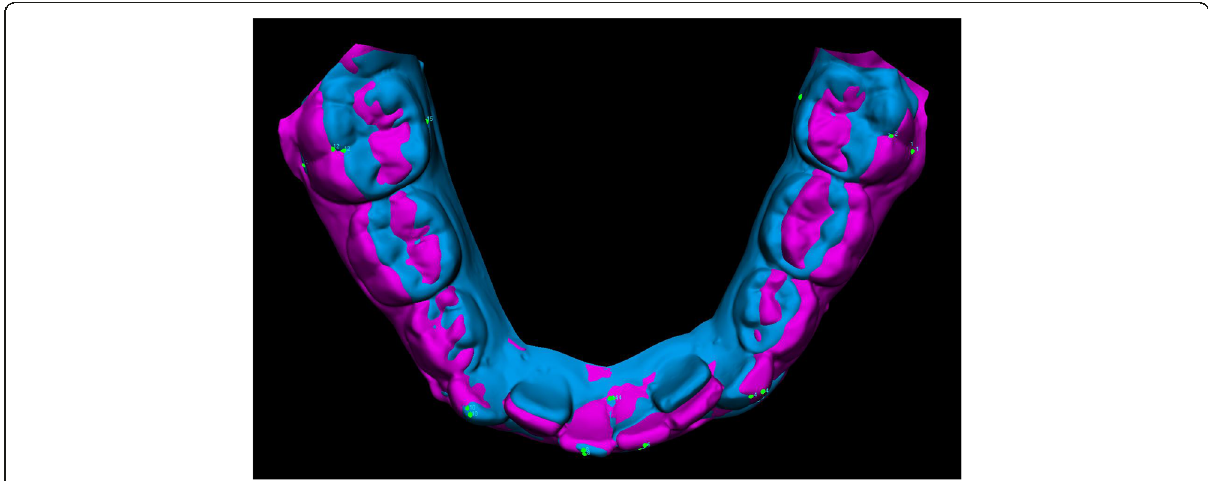
Fig. 2 Superimposition of pre- and post-treatment digital models of the mandible shown as example of mandibular response to RPE